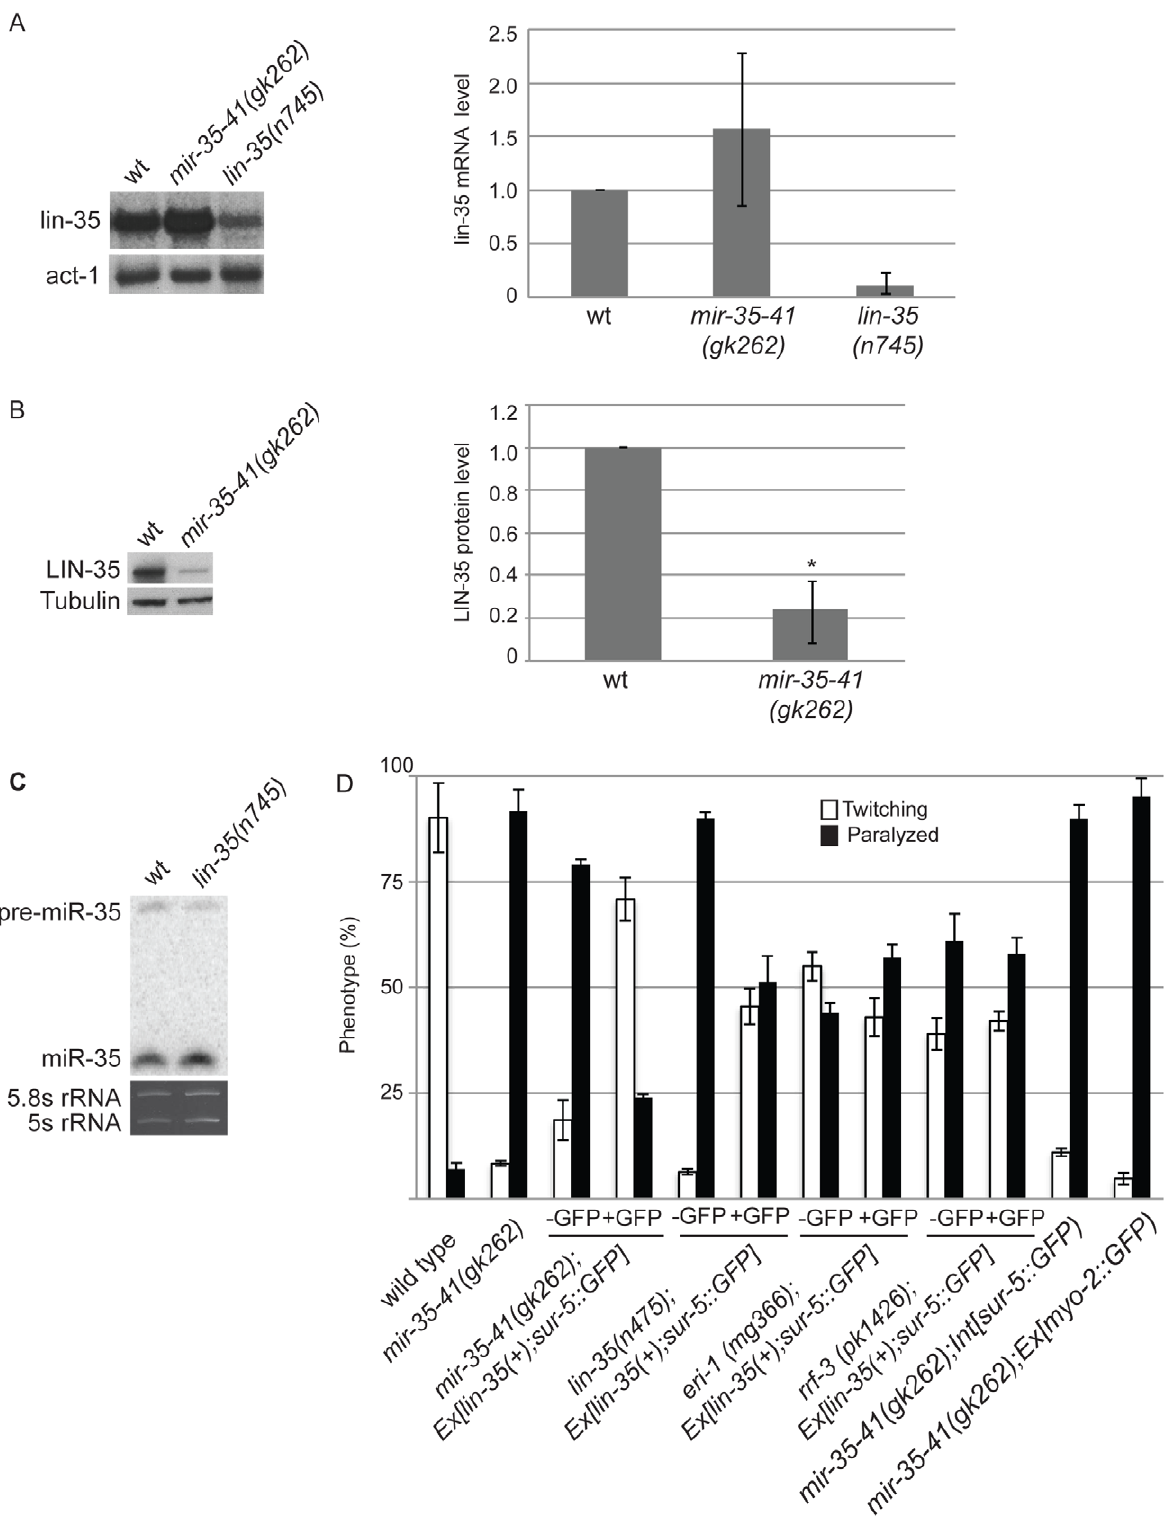
Figure 4. Decreased LIN-35/Rb contributes to the RNAi hypersensitivity of mir-35-41(gk262) worms. (A) Northern blot analyses of lin-35/ Rb mRNA levels in WT, mir-35-41(gk262) and lin-35(n745) embryos. After normalization to actin mRNA the average and standard deviation from 3 independent experiments was calculated with wild type levels set to one. (B) LIN-35 protein is decreased in mir-35-41(gk262) embryos compared to wild type, as shown by western blotting. After normalization to tubulin the average and standard deviation from 4 independent experiments was calculated with wild type levels set to one (Student’s t-test *p , 4 6 10 2 5 ). (C) PAGE Northern blot analysis of RNA from wild type and lin-35(n475) embryos shows similar levels of pre- and mature miR-35 expression. The rRNAs are shown as loading controls. Results are representative of 3